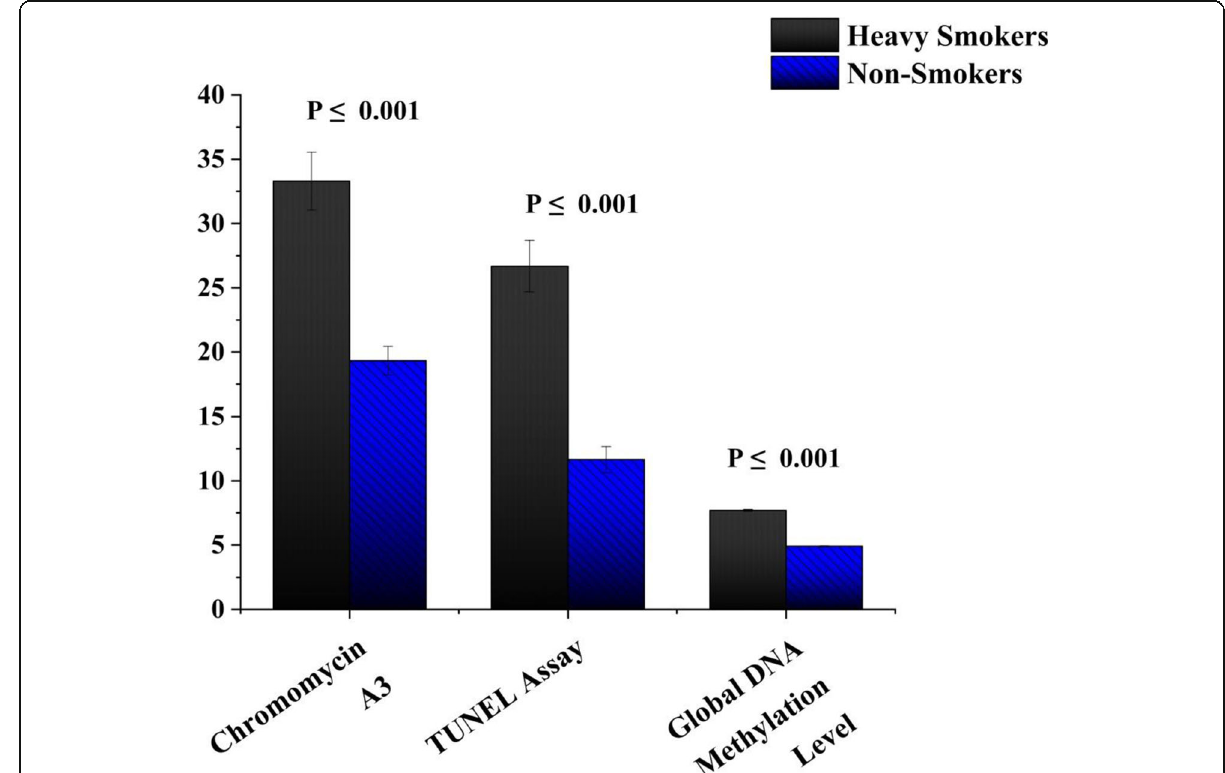
Fig. 1 Global DNA methylation, chromomycin A3, and TUNEL assay in heavy smokers compared to non-smokers. P > 0.05: not significant; P < 0.05: significant. Chromomycin A3: sperm chromatin non-condensation; TUNEL assay: sperm DNA